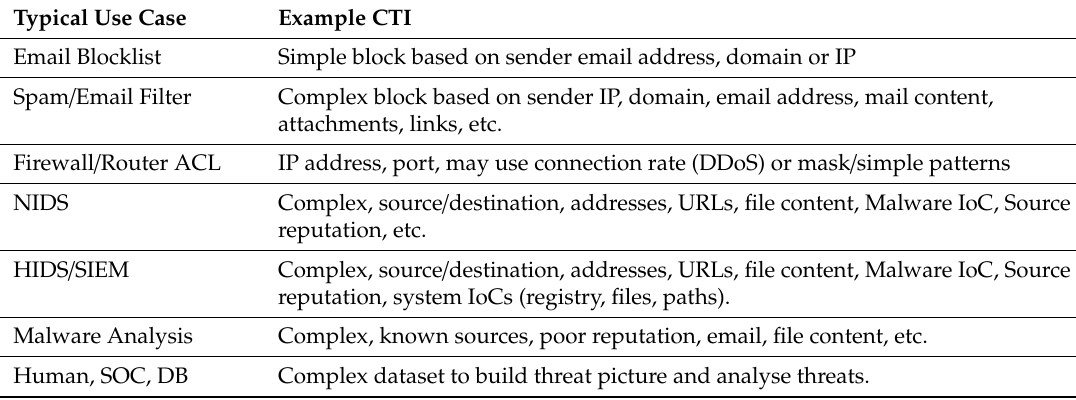
Table 8. Typical use case and example